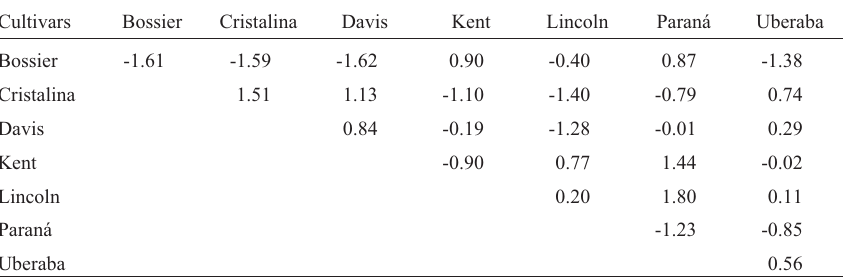
) for the characters evaluated in the assay of soybean reaction to C. sojina , involving seven ii